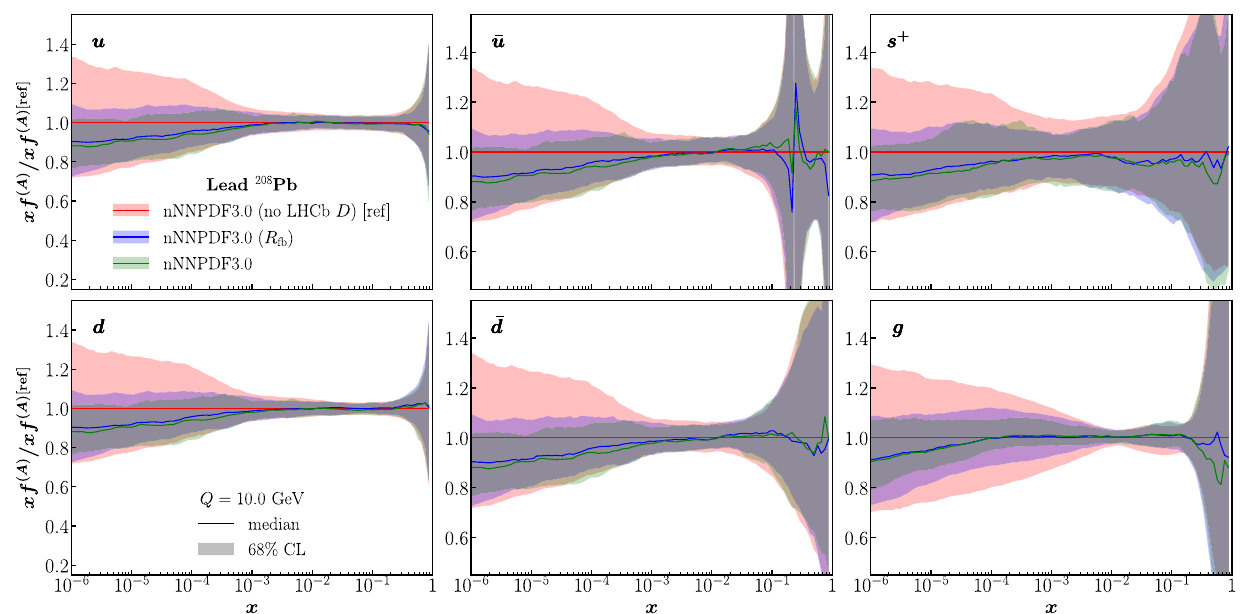
Fig. 27 The impact of the D 0 -meson production data from pPb colli- sions on the lead PDF at Q = 10 GeV. We compare the nNNPDF3.0 prior set with the outcome of the reweighting with the LHCb D 0 -meson